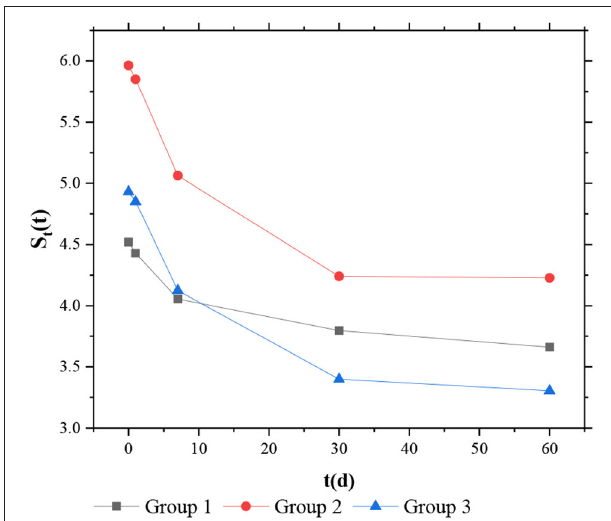
FIGURE 5 | Curve of relationship between thixotropic sensitivity and curing time.